Question: Summarize what this figure shows in one sentence.
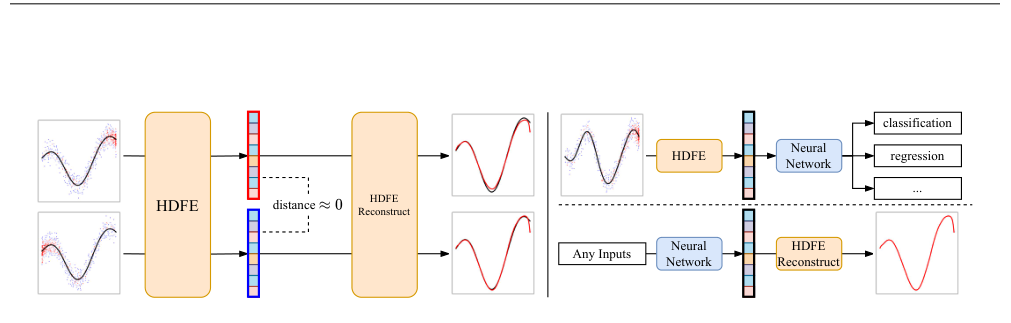
Answer: Left: HDFE encodes continuous objects into fixed-length vectors without any training. The encoding is not affected by the distribution and size with which the object is sampled. The encoding can be decoded to reconstruct the continuous object. Right: Applications of HDFE. HDFE can be used to perform machine learning tasks (e.g. classification, regression) on continuous objects. HDFE also enables neural networks to regress continuous objects by predicting their encodings.